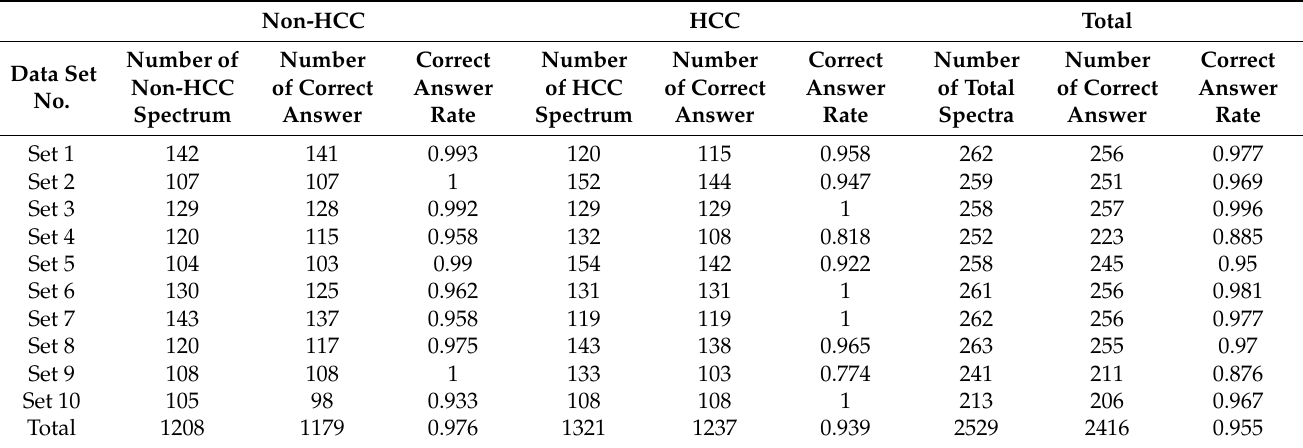
Table 2. K-fold cross validation results both for Non-HCC and HCC